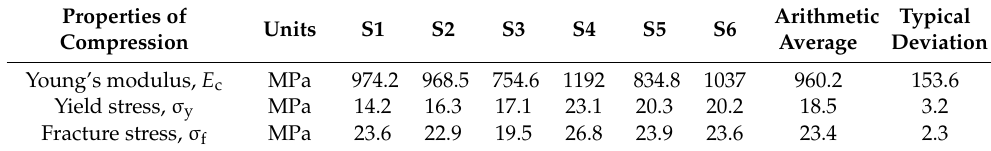
Table 7. Elastic and mechanical properties of Nylstrong GF–PA6 for each Z-axis specimen.